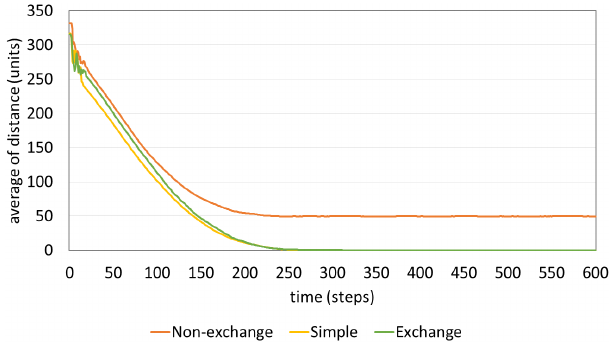
Fig. 20. Comparison of the values of D average for simple approach (ignoring clash judgement), the non- exchange approach (no migration) and the exchange approach (performing migration for exchanging robots).